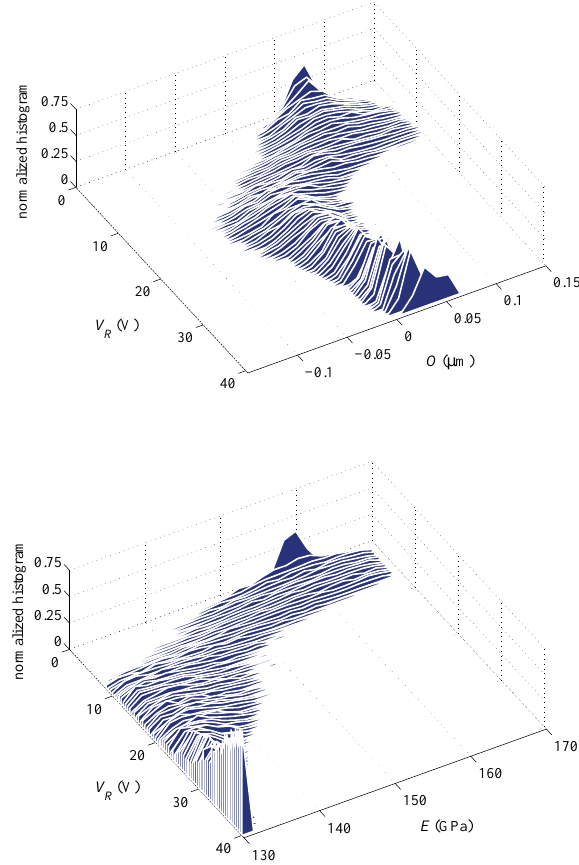
Figure 10. Specimen #5, rotational actuation case, ξ O = ξ E = 0.75: evolution of the PDFs of ( a ) O and ( b ) E corresponding to the evolution of estimates represented by blue curves in Figure